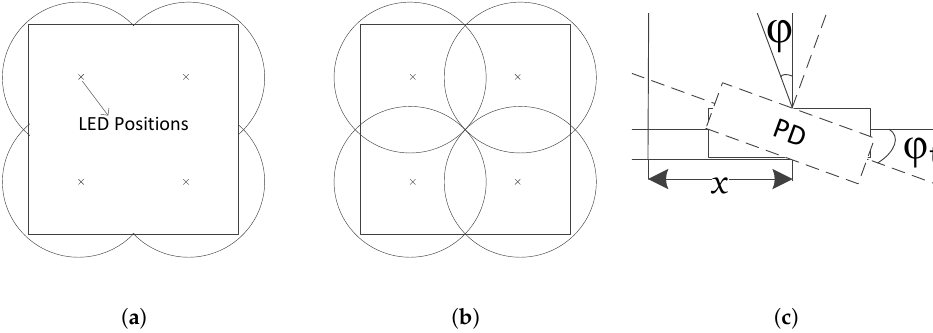
Figure 1. Illustration of top view of room showing the overlap of LED beams and tilted receiver tilting away from the transmitter where ϕ is the angle of incidence and x is the horizontal